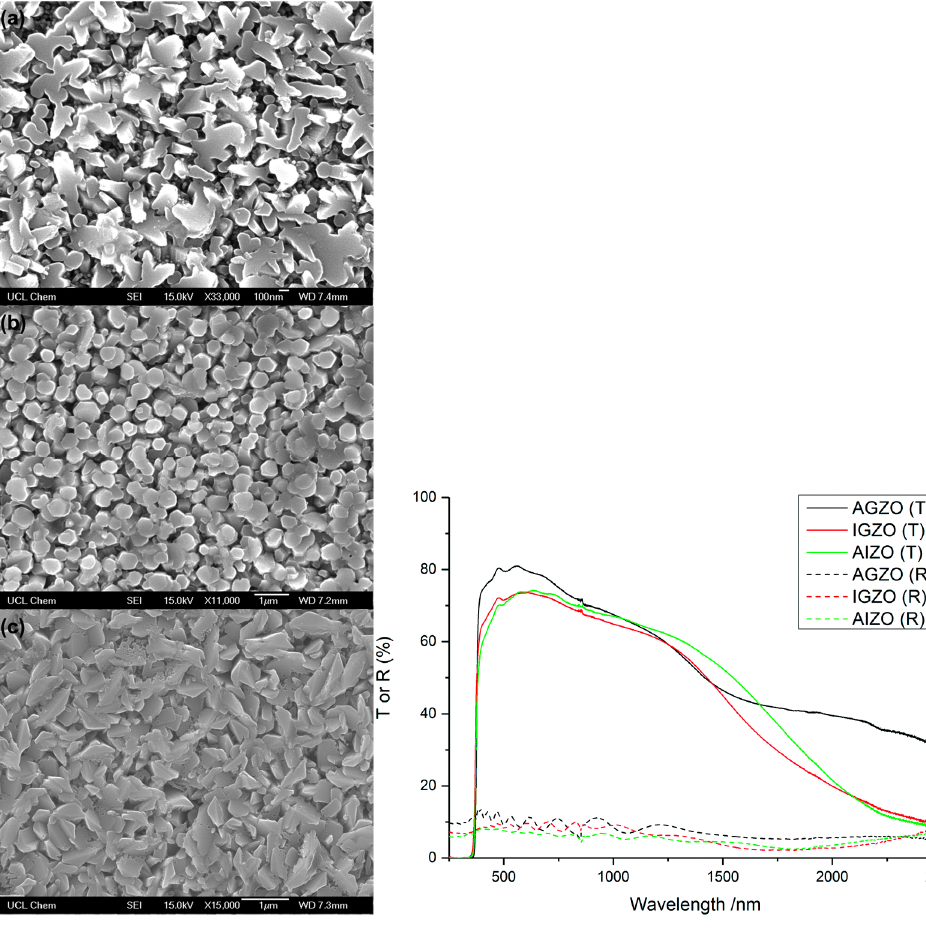
Figure 8. ( Left ) SEM images of the ( a ) AGZO, ( b ) IGZO, and ( c ) AIZO thin films. ( Right ) Transmission–reflectance spectra of the AGZO, IGZO, and AIZO films. All the films were deposited at 450 °C. Reproduced with permission from ref. [25].